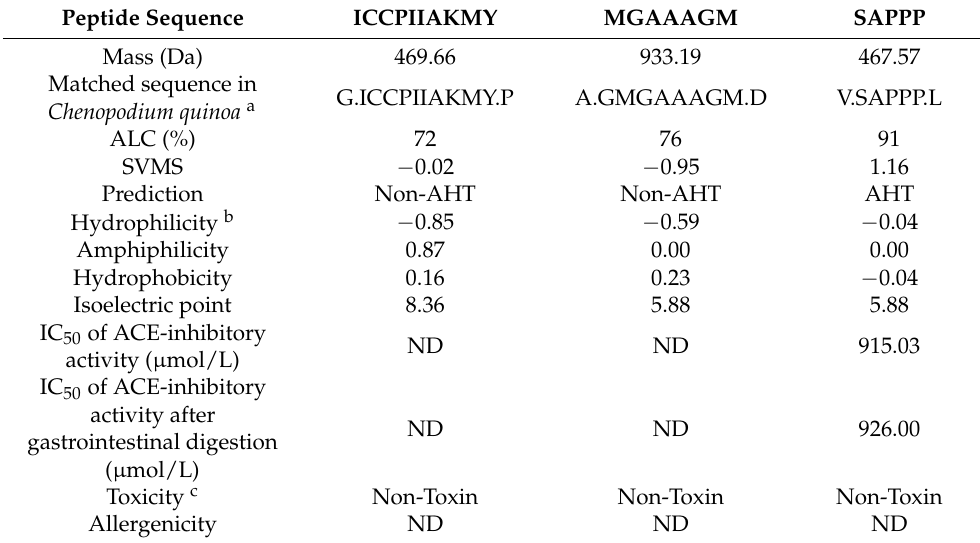
Table 1. Amino acid sequence, in silico screening of ACE-inhibitory and antihypertensive activity, in silico prediction of physicochemical properties, toxicity and allergenicity of peptides identified in quinoa bran globulin hydrolysates by